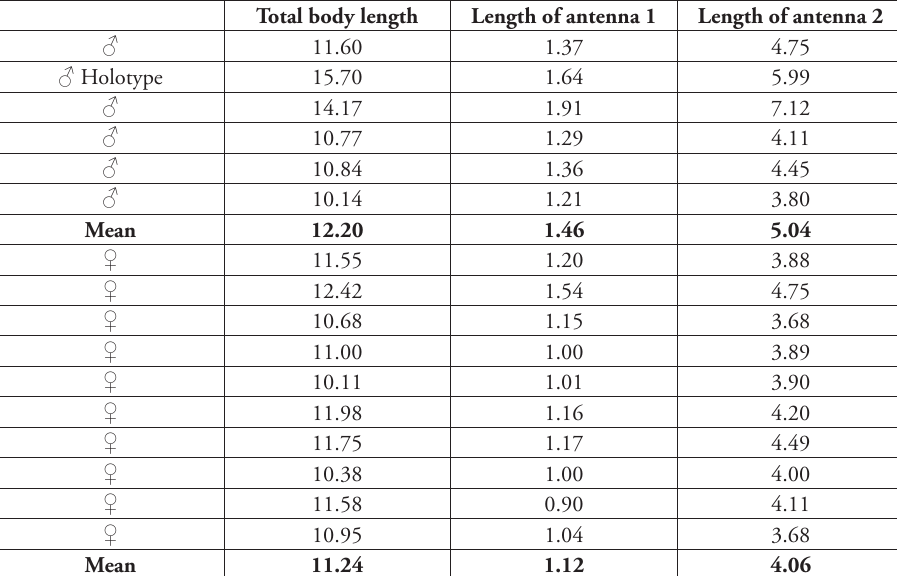
Table 2. Cryptorchestia ruffoi sp. n. Measurements of body length and antennae, showing differences in male and female